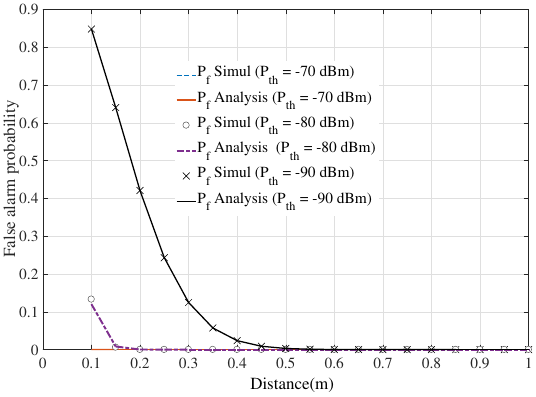
Figure 5. False alarm of the system under different threshold levels of receiver filter.